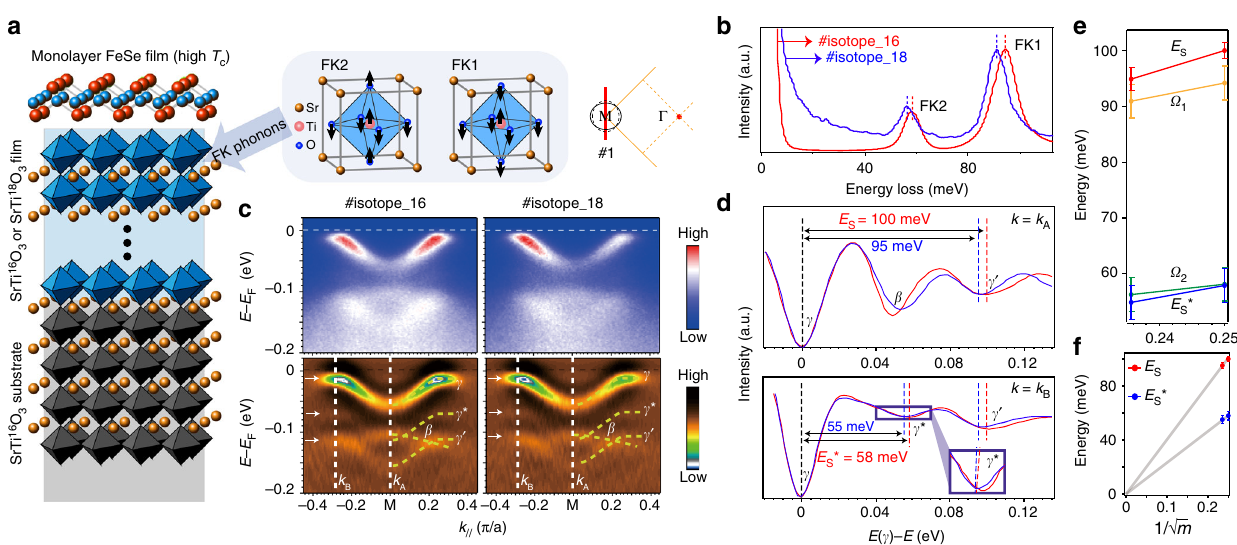
Fig. 1 Isotope dependence of the phonon features. a Sketch of the single-layer FeSe fi lm grown on 60 unit cells of either SrTi 16 O 3 (ST 16 O) or SrTi 18 O 3 (ST 18 O) fi lm, each grown on an ST 16 O substrate. Ionic displacement patterns of the two Fuch – Kliewer (FK) phonons are illustrated. b Electron energy loss spectra measured by high-resolution EELS for a FeSe/ST 16 O (this sample is referred to as #isotope_16) and a FeSe/ST 18 O (#isotope_18). Ω 1 and Ω 2 are the phonon energies of the two FK phonons FK1 and FK2, respectively. c Photoemission intensity across M along cut #1 shown in the upper-middle inset and the corresponding second derivative with respect to energy to highlight the dispersions in #isotope_16 and #isotope_18. d Second derivative of the energy distribution curves (EDCs) with respect to the binding energy for #isotope_16 and #isotope_18 of the γ band at the momenta k A and k B as indicated in panel c . E S and E S * are the energy separations between γ ′ and γ , and between γ * and γ , respectively, as obtained from in situ ARPES. e E S , E S *, Ω 1 , and Ω 2 as a function of the inverse square root of oxygen masses. f E S and E S * as a function of the inverse square root of oxygen masses and the corresponding linear fi ts through the origin, demonstrating their proportional relationship. The error bar in energy is from the standard deviation of the data in 18 samples (Supplementary Figure the γ ′ band; consistent with this, the replica band separation energy is noticeably larger than the corresponding phonon energy for γ ′ while not for γ * (Fig. 1e). Next we focus on γ ′ which represents the stronger interfacial EPI.